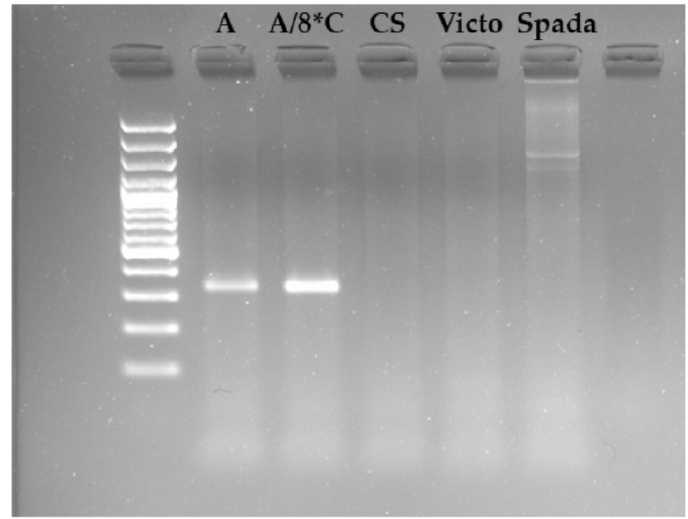
Figure 3. Marker Pm 1aSTS1 assay showing specificity to Pm 1a-containing T. aestivum lines. Victo, Spada, and Chinese Spring (CS) do not have the Pm 1a gene, while Axminster (A) and Axmin- ster/8*Chancellord (A/8*C) do have it.